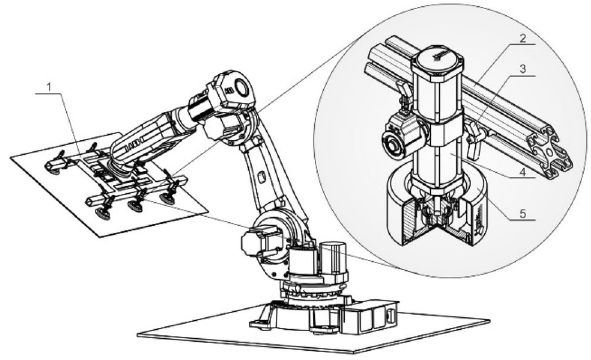
Fig. 30 Industrial robot with multi-element gripping head Fig. 31 Functional samples of designed gripping